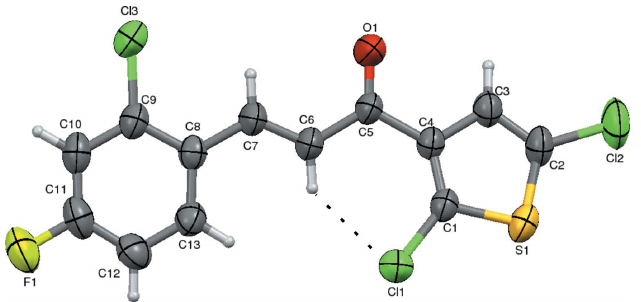
Figure 1 The molecular structure of the title compound, indicating the atom- numbering scheme. The intramolecular C—H (cid:3)(cid:3)(cid:3) Cl hydrogen bond (dashed line) closes an S (6) motif. Displacement ellipsoids are drawn at the 50% probability